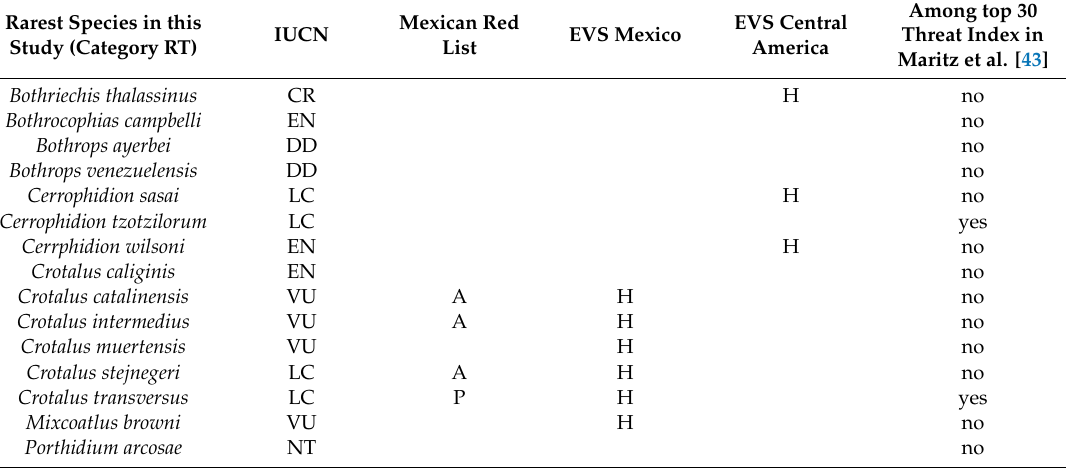
Table 2. Comparison of the categorization of New World pitvipers of this study (only the rarest, RT category) with those of extinction risk assessments by IUCN ([42] for the World), Secretar í a de Medio Ambiente y Recursos Naturales ([78] for Mexico), Johnson et al. ([76] for Central America), Wilson et al. ([77] for Mexico), and the Threat Index of Maritz et al. ([43] for the World). Categories in the Mexican red list are: A = Amenazada (threatened) and P = En Peligro de Extinci ó n (endangered). Category H (high vulnerability species) in the studies using the Environmental Vulnerability Score (EVS) system indicates a score ≥ 14 (see [75]). An empty cell indicates that the species was not assessed. Rarest Species in this Mexican Red IUCN Study (Category RT) List